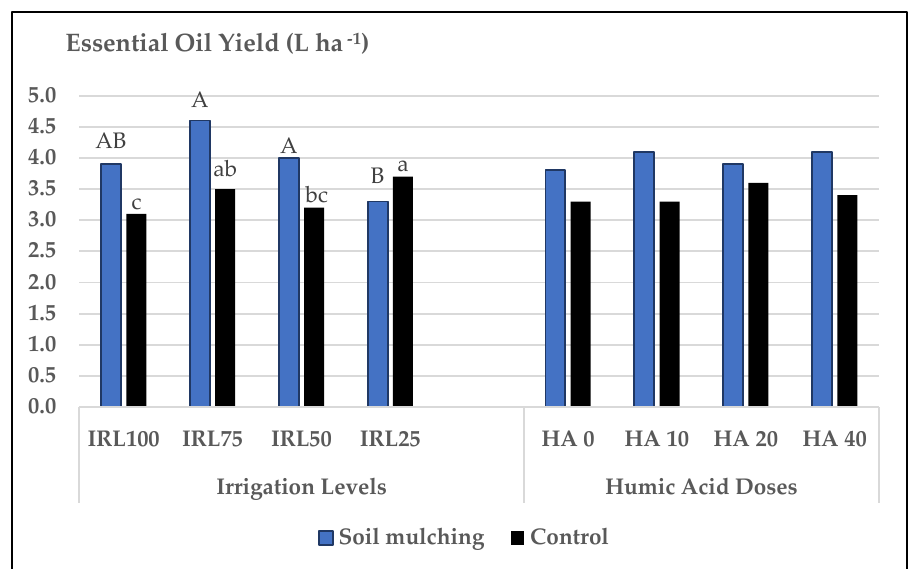
Figure 8. Mean values of EOY of O. basilicum L. under soil mulching and control conditions. IRL 100 = 100% FC; IRL 75 = 75% FC; IRL 50 = 50% FC; IRL 25 = 25% FC; HA 0 = 0.0 Lha − 1 ; HA 10 = 10.0 Lha − 1 ; HA 20 = 20.0 Lha − 1 ; HA 40 = 40.0 Lha − 1 .